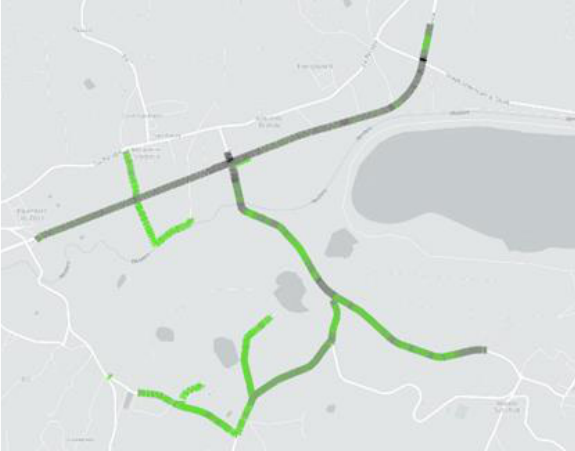
Figure 3 . Representation of the slow mobility analysis applied to Pietrafitta.